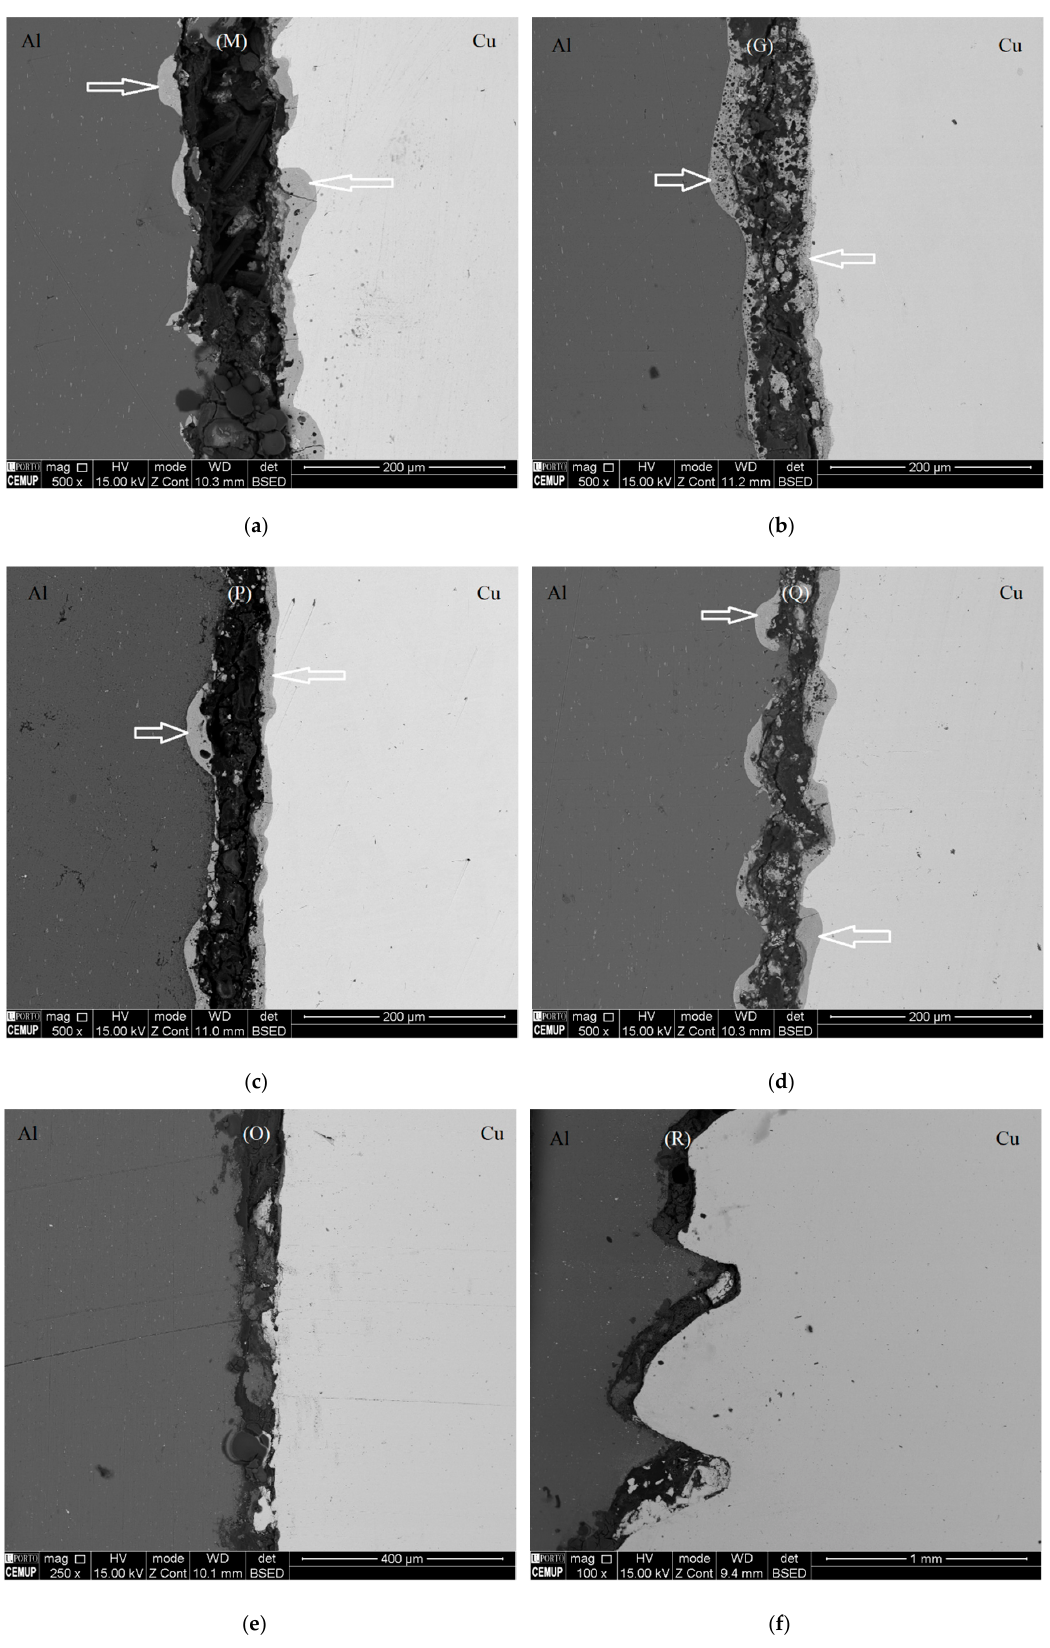
Figure 4. SEM / BSE images from the ( a ) Al / Cu-M, ( b ) Al / Cu-G, ( c ) Al / Cu-P, ( d ) Al / Cu-Q, ( e ) Al / Cu-O, Figure 4. SEM/BSE images from the ( a ) Al/Cu-M, ( b ) Al/Cu-G, ( c ) Al/Cu-P, ( d ) Al/Cu-Q, ( e ) Al/Cu-O, and ( f ) Al / Cu-R joints produced by MPW and ( f ) Al/Cu-R joints produced by MPW technique. Table 6. The average thickness (in μ m) of intermetallic layers formed at the interface of the joints obtained in this study.